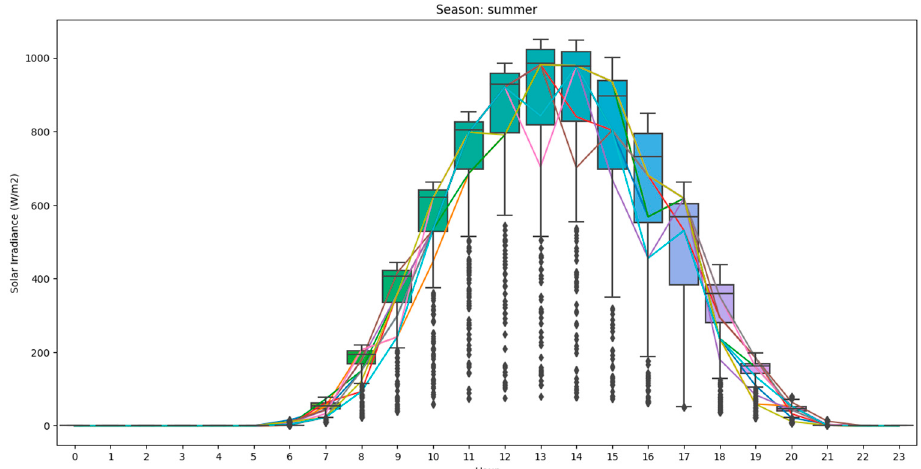
Figure 15. Ten preserved scenarios plotted over the box-whisker plot of the observed solar irradiance